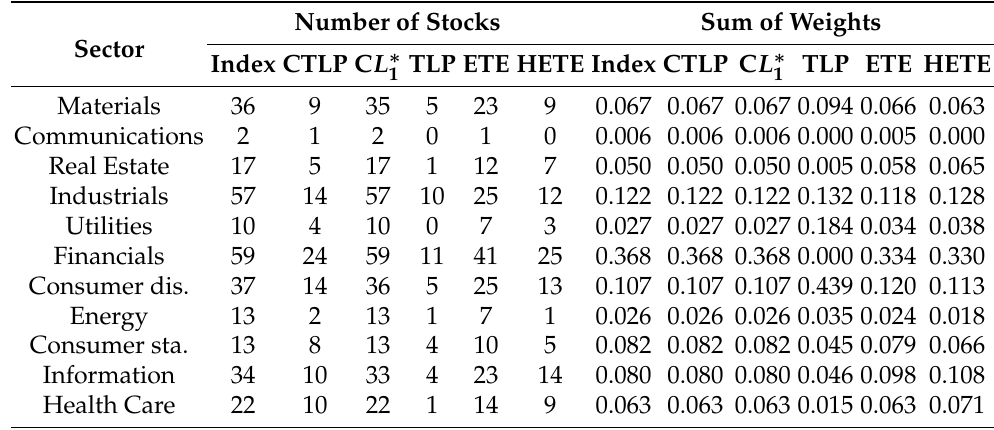
Table 11. The number of stocks and the sum of weights within sectors in selected portfolio by different methods and the index in